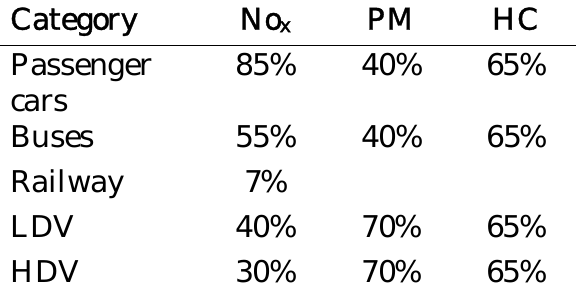
Table 13. Assumptions on technological developments in BAU Scenario (Aichi Prefecture) PM, HC Emission factors